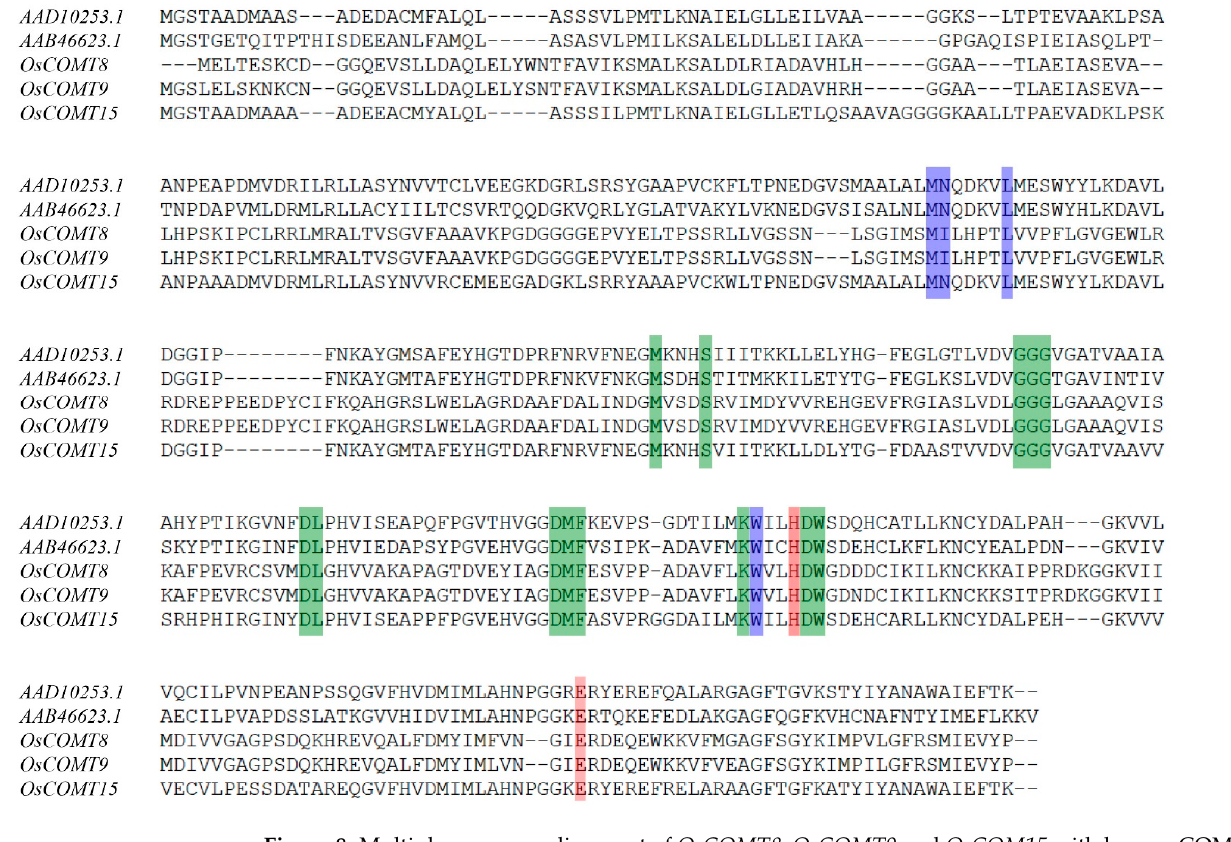
Figure 7. ( A ) Lignin content in five growth stages of rice stem. ( B ) Expression of OsCOMTs in rice stem at five different stages. S1: Seedling stage, S2: Tillering stage, S3: Booting stage, S4: Heading stage, S5: Filling stage.